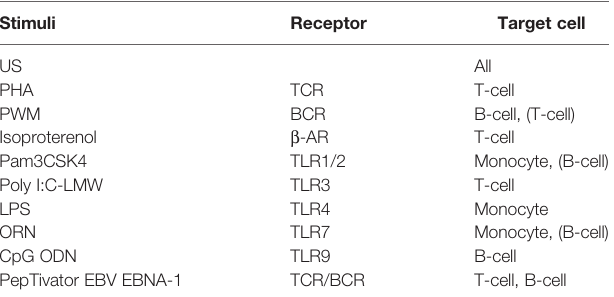
TABLE 2 | Stimulants in the in vitro assay.